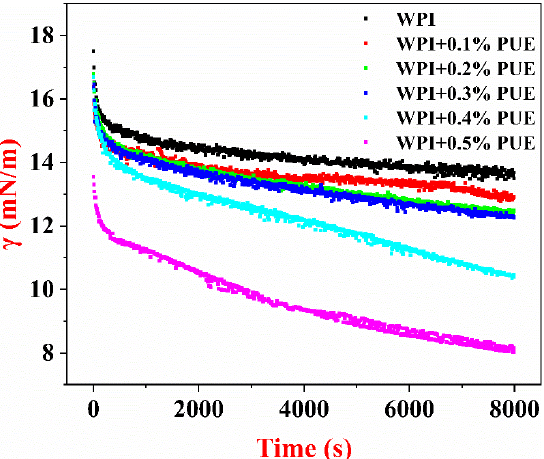
Figure 5. D ynamic interfacial tension (γ) of WPI only or the WPI – PUE composites at the oil – water Figure 5. Dynamic interfacial tension ( γ ) of WPI only or the WPI–PUE composites at the oil–water interface with increasing adsorption time. interface with increasing adsorption